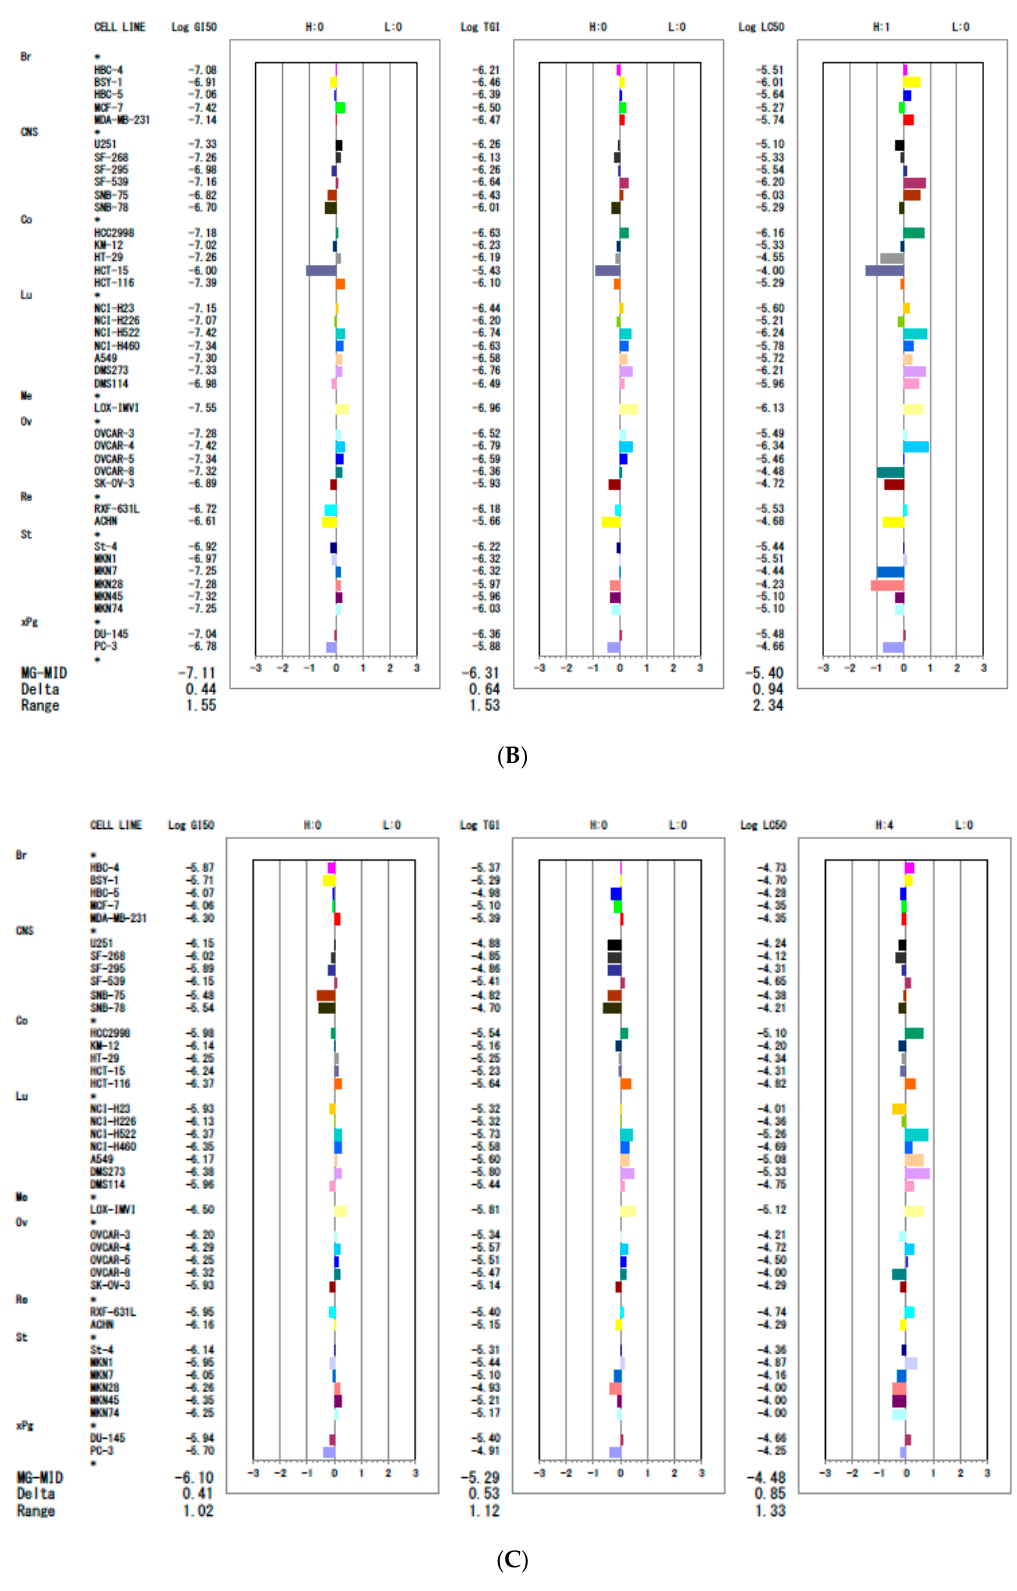
Figure 6. Growth inhibitory- and cytotoxic activities of compounds ( A ) 7d , ( B ) 7k , and ( C ) 7q across a panel of the JFCR39 cell lines. The mean graph was produced by computer processing of the 50% growth inhibition (GI 50 ) and the 50% lethal concentration (LC 50) values. The logarithm of the GI 50 and the LC 50 values for each cell line is indicated. The X-axis shows the di ff erence on a logarithmic scale between the mean of Log GI 50 / Log LC 50 values for all 39-cell lines (MG-MID, expressed as 0 in